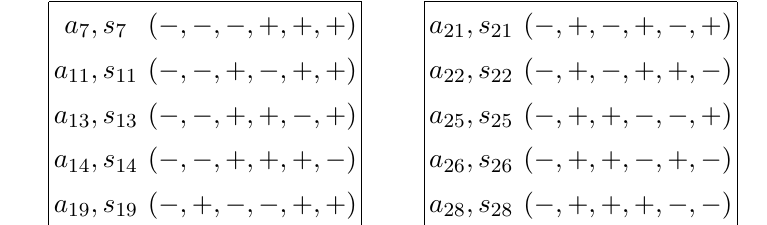
Table 1 . a - and s -type amplitudes and their corresponding n -tuples for the case n = 6 . The numbering scheme is described in section 3.1.